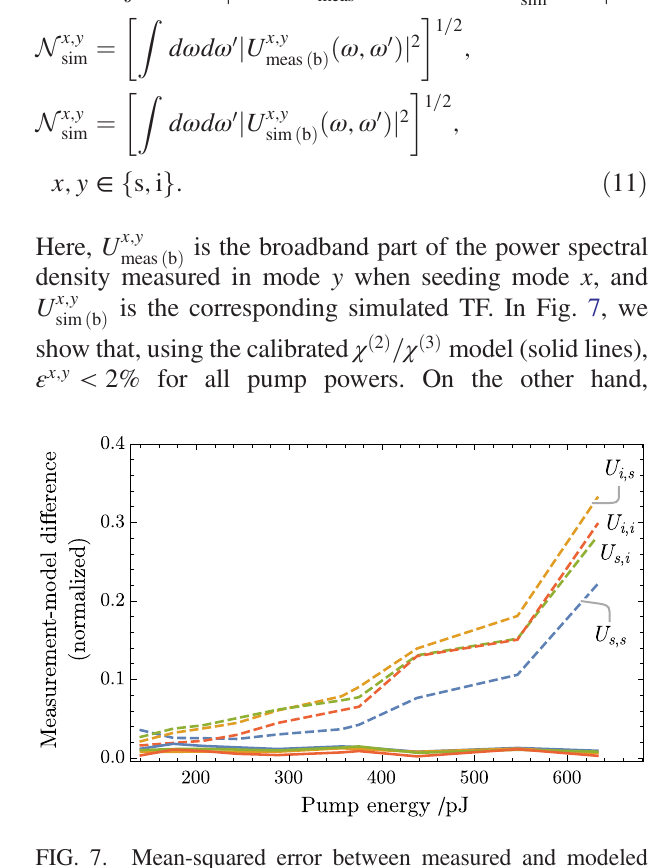
FIG. 7. Mean-squared error between measured and modeled TFs (details in the Sec. III.D). Solid lines are for the χ ð 2 Þ = χ ð 3 Þ model; dashed lines are for the χ ð 2 Þ